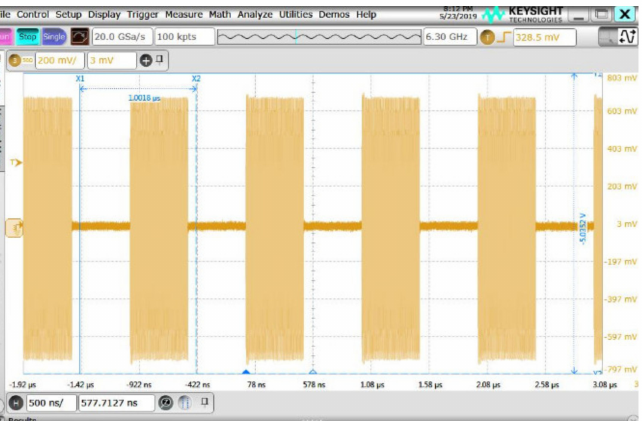
Figure 14. Time domain measurement results for the ON and OFF state of the switch for one channel. The speed of the ON/OFF is 10 MHz and the carrier frequency is 1